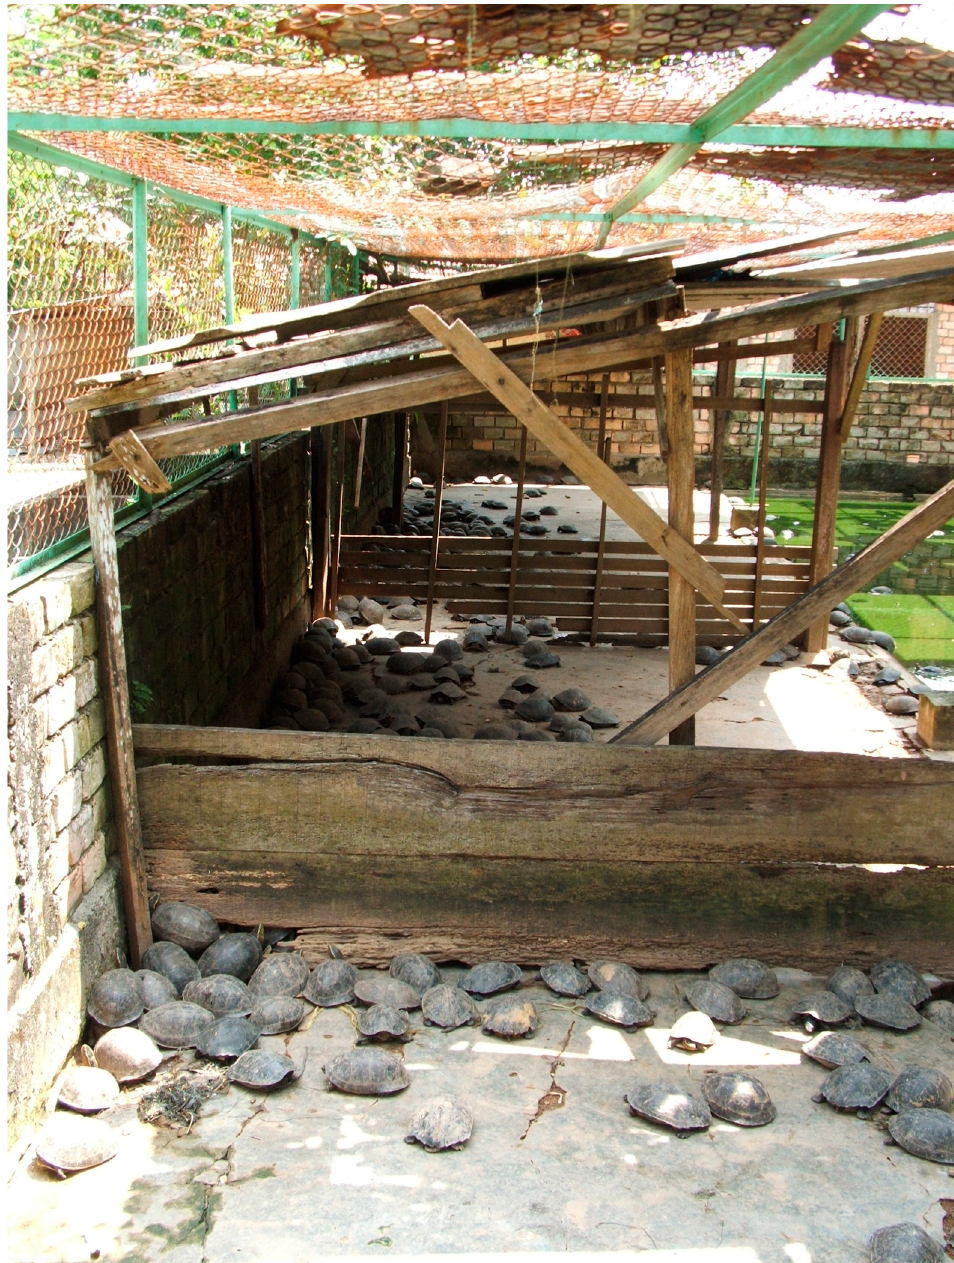
Figure 2. Southeast Asian box turtles Cuora amboinensis are a trader’s in Palembang, South Sumatra, Indonesia. On the day of the visit, it was estimated that 500 turtles were present—this was half the annual quota for the province of South Sumatra (photo: V. Nijman).